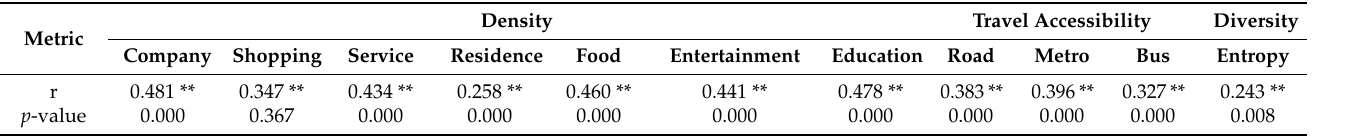
Table 3. Relationships between built environment factors and nighttime economy–housing imbalance intensity.